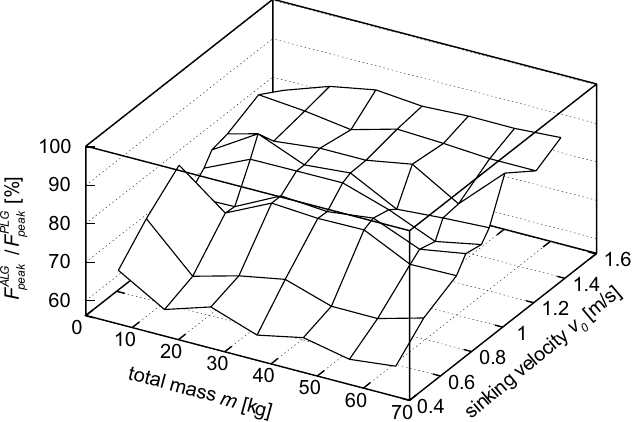
Fig. 20. Active control experimentally compared to passive control: ratio of the measured peak dynamic forces, cf. Fig. 10.